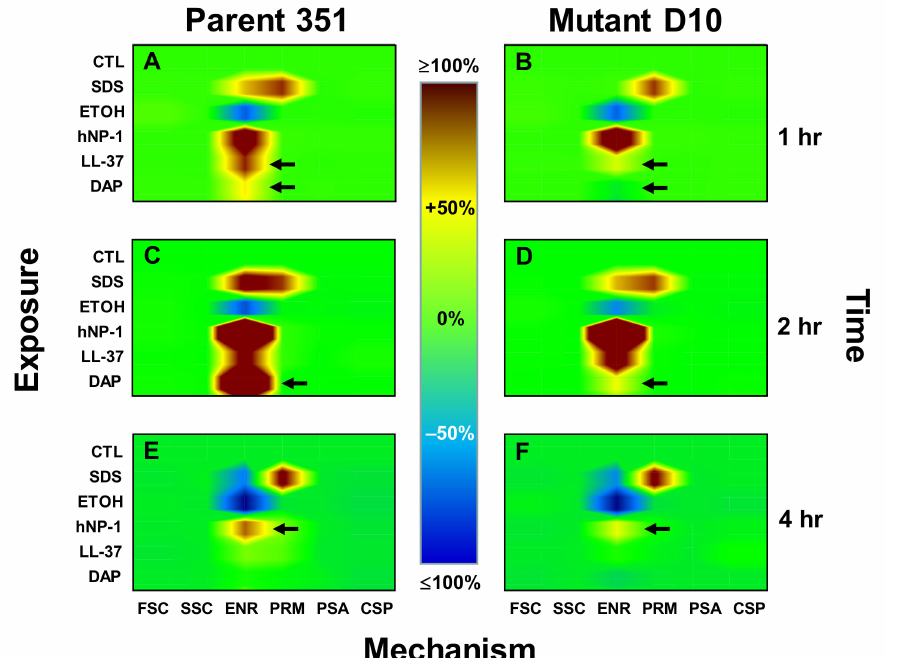
Figure 3. Mechanistic signature mapping of DAP and HDPs against 351 DAP-S and 351-D10 DAP-R study strains in vitro. Exposure conditions ( y axis) included control (CTL) (buffer alone), the indiscriminant membrane detergent sodium dodecyl sulfate (SDS), hNP-1, LL-37 and DAP, as detailed in the Methods Section. Mechanisms of action ( x axis) were determined using multicolor flow cytometry: forward scatter (FSC) (cell size/shape), side scatter (SSC) (intracellular refraction indicative of cytoplasm condensation), cellular energetics (ENR) (transmembrane potential), CM permeabilization (PMR) (propidium iodide uptake), negatively charged phospholipid accessibility (PSA) (cytoplasmic membrane turnover (e.g., extracellular exposure of intracellular leaflet bilayer)) and cell death protease activation (CDP). Percent increases (yellow-orange-red) or decreases (blue- indigo-violet) in respective mechanisms of action recorded 1–4 h post exposure are integrated within each mechanistic fingerprinting map panel, each representing >1 million data points derived from a minimum of 3 independent experiments. Figure panels ( A ), ( C ) and ( E ) indicate kinetic response mechanisms in parent strain WT-351 at 1, 2 and 4 hrs, respectively; panels ( B ), ( D ) and ( F ) indicate comparative responses in the mutant 351-D10 strain at the identical